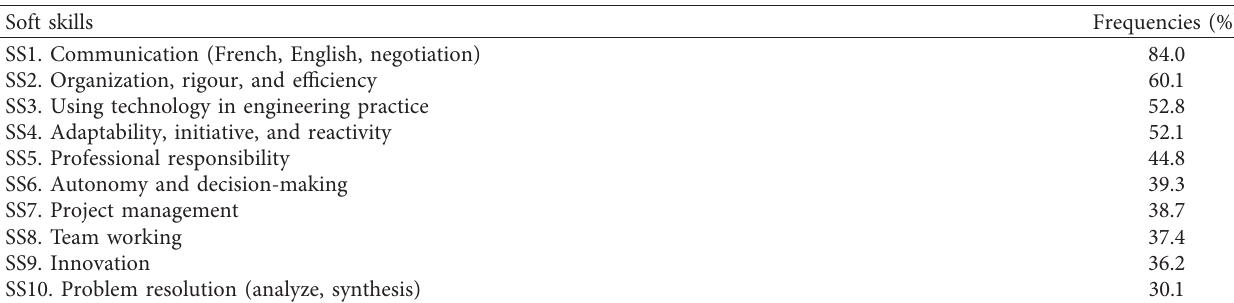
Table 3: Soft skills required by Moroccan job